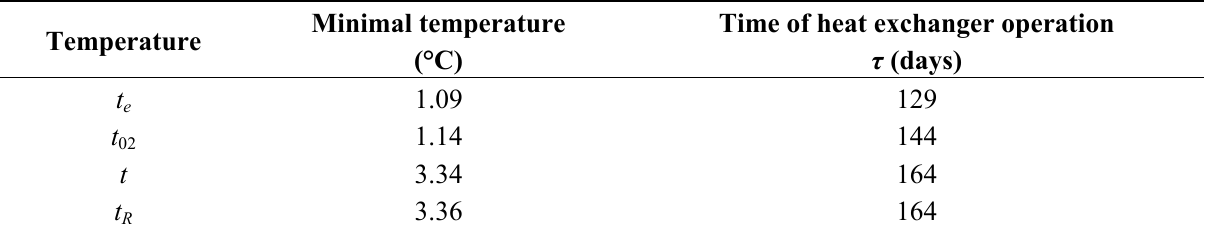
Table 2. Calculated minimal average daily